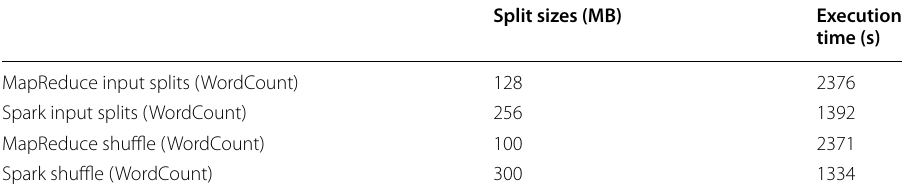
Table 5 The best execution time of MapReduce and Spark with WordCount workload